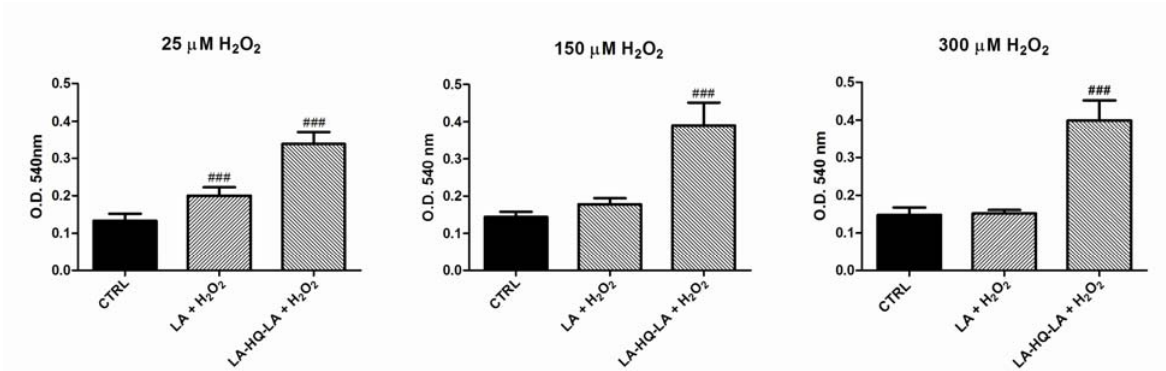
Figure 5. Neuroprotective effects of LA and LA-HQ-LA in RA-differentiated and O -lesioned SH-SY5Y human neuroblastoma cells. H 2 2